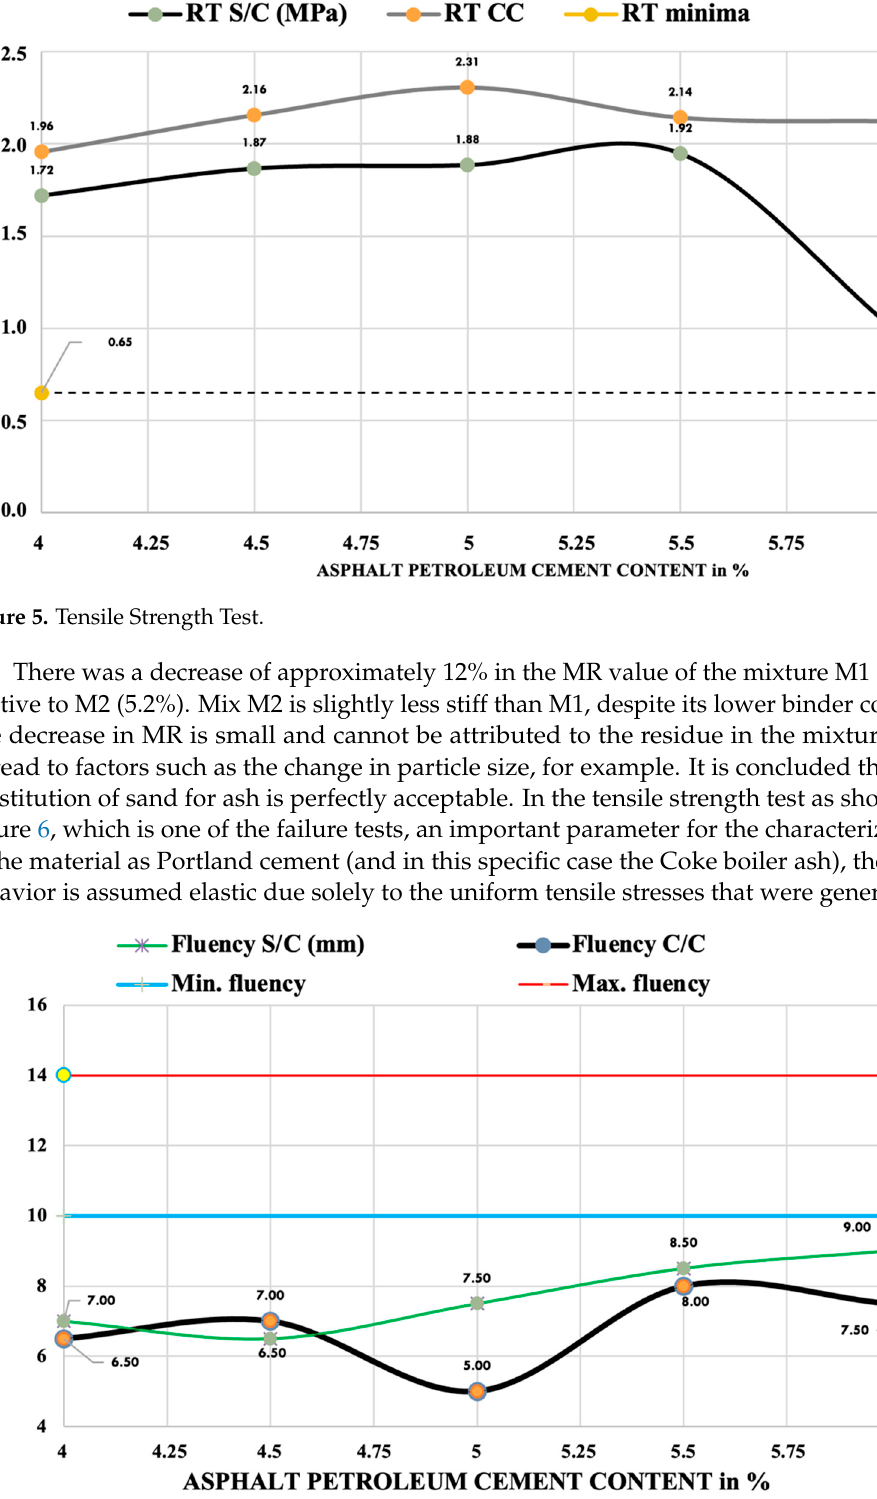
Figure 7. Fatigue life x resilient specific deformation.